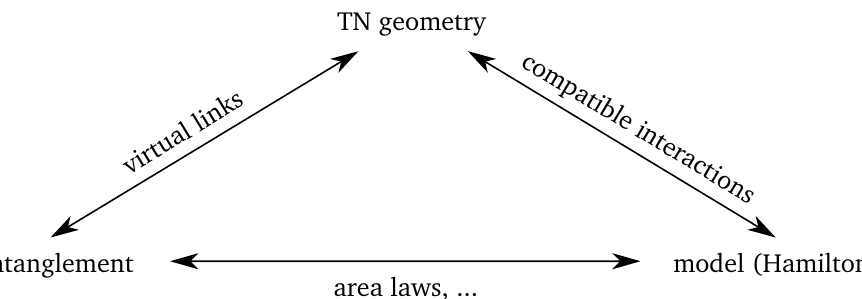
Figure 43: Elements influencing the choice of the TN geometry: The network has to be compatible with the interactions present in the Hamiltonian, and at the same time must be able to capture the ground state entanglement, which in turn is determined by the Hamiltonian